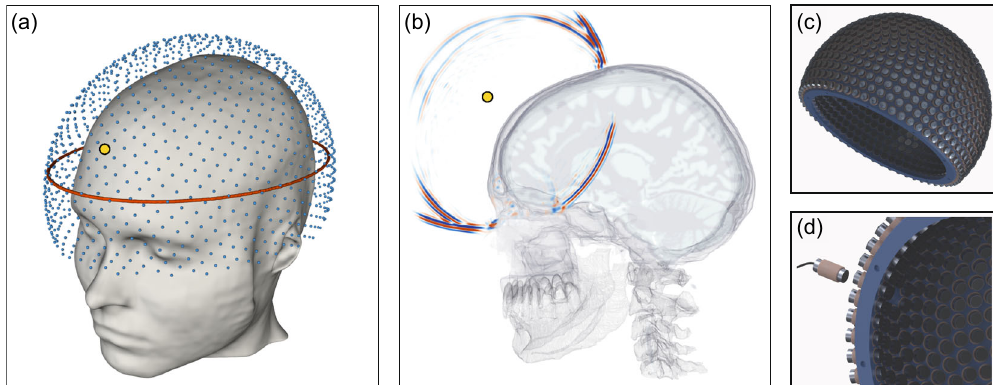
Fig. 1 Experimental geometry. a Three-dimensional array of transducers used for data generation and subsequent inversion. Each transducer acts as both a source and a receiver. The red ellipse shows the location of the two-dimensional array used to generate the data for Fig. 2 and 4. b A snapshot in time of the wave fi eld generated by a source transducer located at the position indicated by the small yellow circle, computed via numerical solution of the 3D acoustic wave equation. The wave fi eld is dominated by strong re fl ections from the skull, and by intracranial transmitted energy travelling across the brain; Supplementary Video 1 shows the full wave fi eld propagating in time. c Prototype helmet containing 1024 transducers held rigidly in a 3D-printed framework. In the prototype device, the framework is customised to provide an accurate fi t to an individual subject, and fi lled with water. In portable clinical devices, the sensors move radially, and contact the patient via sonographic gel. d Close up of sensor connections in the